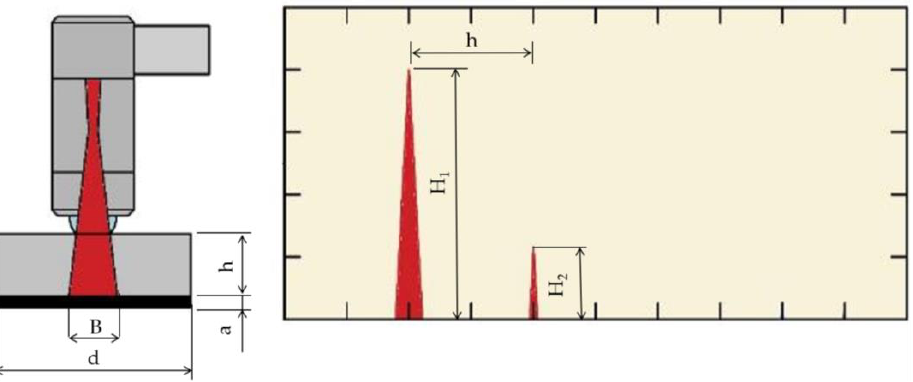
Figure 6. Ultrasonic testing of adhesive joint — scheme; h = 10, 25 and 40 mm, d = 25 mm, a = 1 mm. Twenty ultrasonic measurements of the amplitude of the first two return echoes from the adhesive joint boundary were made for each head and each sample thickness of Ti6Al4V and Ti6Al4V-AM material. The decibel drop between the first and second pulses of the ultrasonic wave from the adhesive-sample boundary was determined by: 𝑅 = 20 × log (𝐻 1 𝐻 2 ) (3) The aggregate results of the decibel drop in the amplitude of the H 1 and H 2 pulses for the additively and conventionally manufactured adhesive-sample joint are shown in Fig- ures 7 and 8. Figure 7. Decibel drop for samples with and without adhesive of Ti6Al4V material.